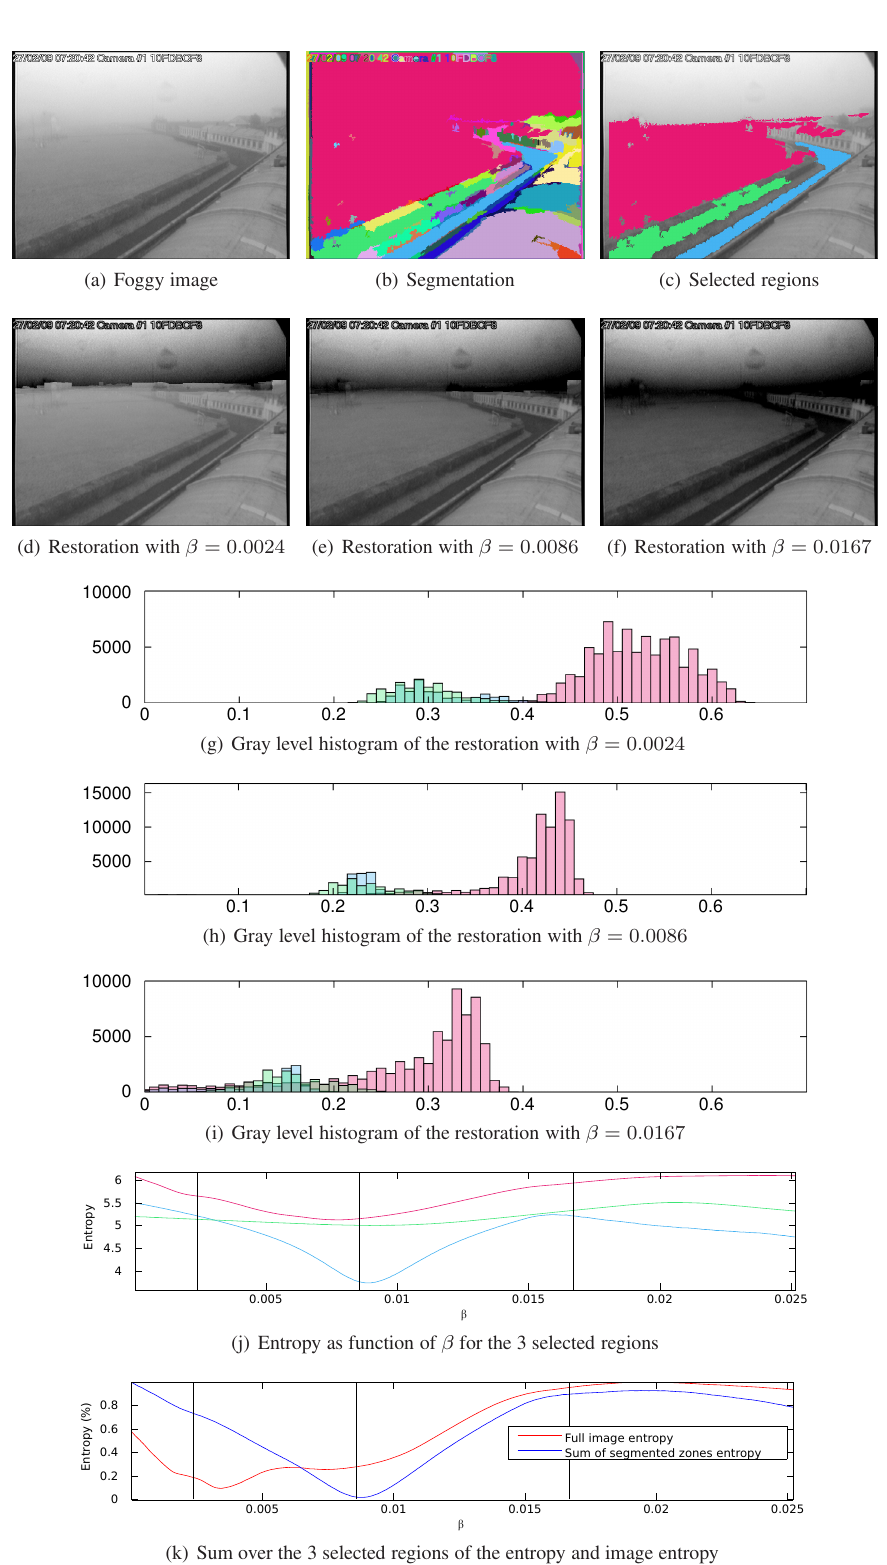
Figure 2: Variation of the entropy with and without segmentation for different values of β . On the first line, 2(a) is the foggy image where the ground-truth is known: β = 0 . 0086 , 2(b) is the used segmentation and 2(c) are the three selected regions. On the second line are the restored images for different value of β , when the depth-map D is known. Next, the gray level histograms of the intensity distribution on the selected regions are shown for three different values of β . Then, 2(j) shows the entropy of the three selected regions versus β and 2(k) shows the sum over the selected regions of the entropy compared to the image entropy. In the last figure, vertical lines displays the value of the three β values used